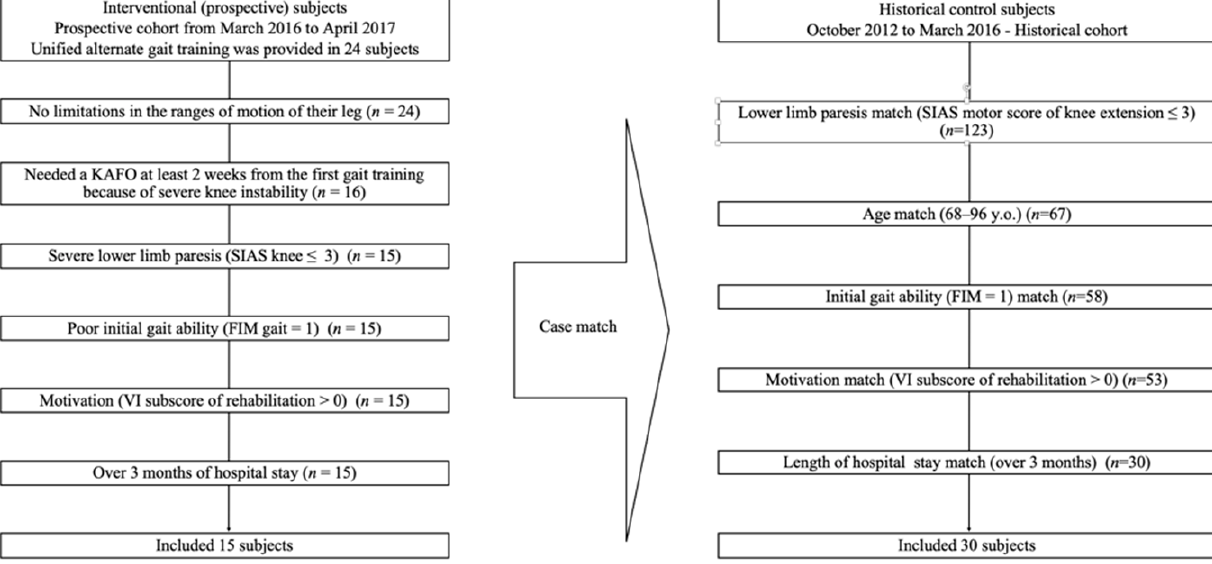
Figure 1. Subject enrollment flowchart.